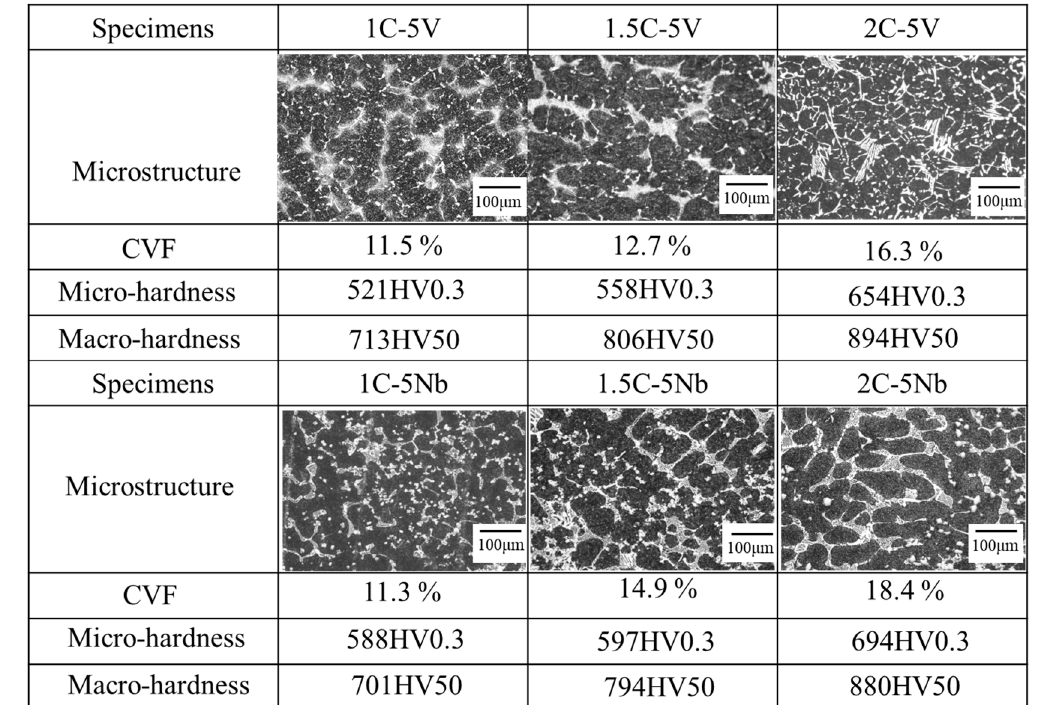
Figure 3. The microstructure, CVF, and Vickers hardness test of the alloys.